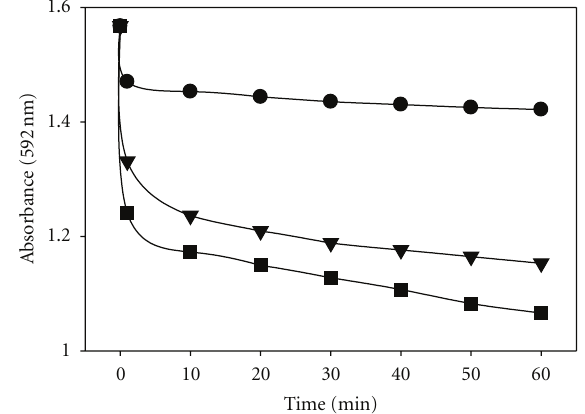
Figure 5: Decolorization of CV dye with UR (nonprotein fraction of extracellular liquid; MW < 10 KDa) obtained after culture of